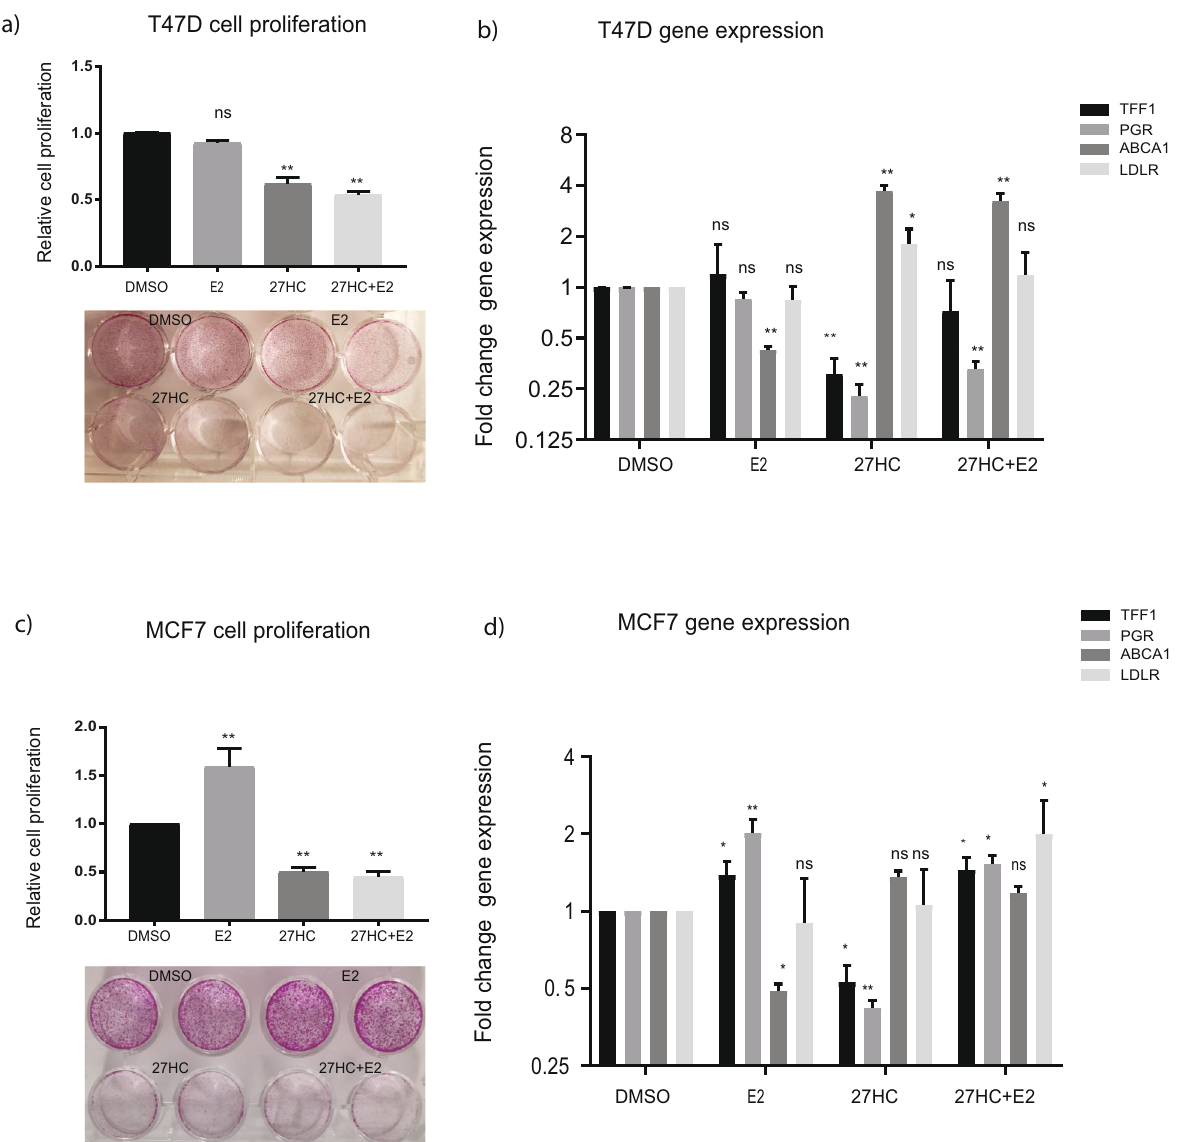
Fig. 4 Effects of 27HC treatment on ER + breast cancer cells under lipid-depleted conditions. T47D and MCF7 cells were treated with 1 μ M 27HC, 1nM of E2, or a combination of both for 72 h and proliferation measured using SRB assay. a , c The quanti fi cation of cell proliferation for T47D and MCF7 respectively under respective treatment conditions. These panels also feature a representative image of post treatment SRB stained cells. After treating the cells under respective conditions, changes in expression of ER target genes TFF1, PgR, and LXR target genes ABCA1, LDLR was measured by qRT-PCR. b , d The fold change in gene expression in T47D and MCF7 cells, respectively. Quanti fi cations are presented as fold change compared to vehicle DMSO treatment. All data are shown as the mean + / – SD of at least two representative experiments. * p < 0.05, ** p <